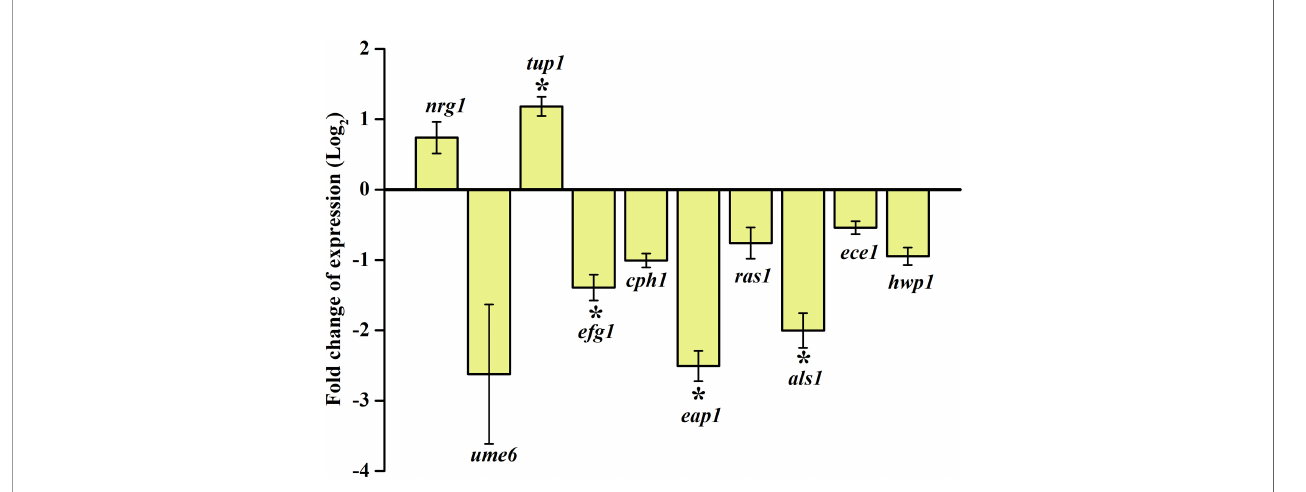
FIGURE 10 | Dynamics in the expression of candidate genes under the in fl uence of synergistic combinations of piperine and thymol. Negative and positive regulators of fi lamentation, nrg 1 , tup1 , and ume6 are upregulated and downregulated, respectively. Other genes responsible for adhesion, bio fi lm formation, and fi lamentous growth are found to be downregulated.